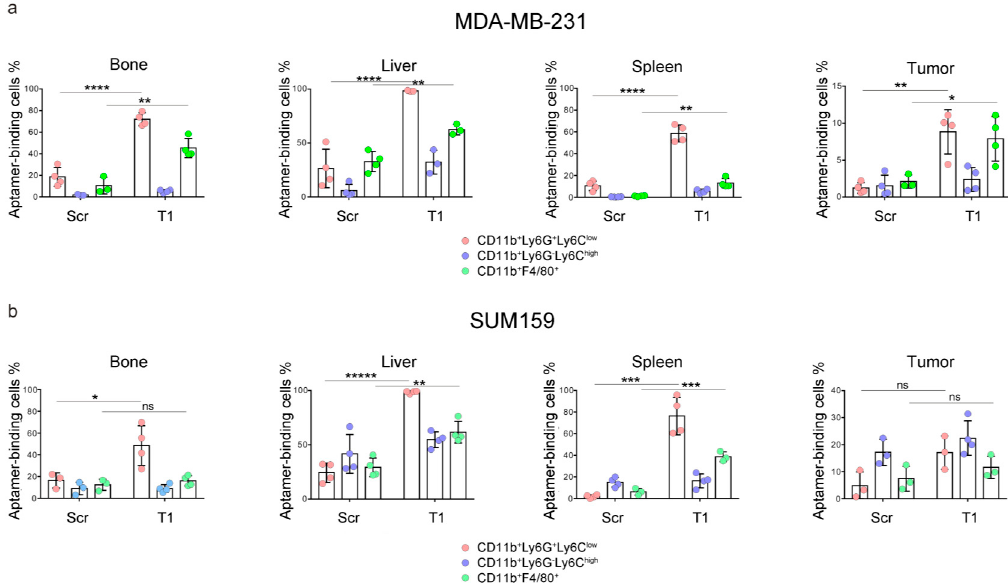
Figure 3. Analysis of aptamer-binding myeloid cells in a murine model of MDA-MB-231 and SUM159 xenograft tumors. Mice bearing primary ( a ) MDA-MB-231 or ( b ) SUM159 primary tumors ( n = 4 mice / group) were treated with Cy5-labeled T1 or scramble aptamer. They were euthanized 4 h later, and single cells were prepared from bone marrow, liver, spleen and tumor tissues. Flow cytometry was performed to detect aptamer-positive cells. Pink: CD11b + Ly6C low Ly6G + granulocytes; Blue: CD11b + Ly6C high Ly6G − M-MDSCs; Green: CD11b + F4 / 80 + macrophages. Data is presented as mean ± s.d. p values are calculated with a two-tailed student t -test. *, p < 0.05; **, p < 0.01; ***, p < 0.001; ****, p < 0.0001; *****, p < 0.00001; ns, not significant.